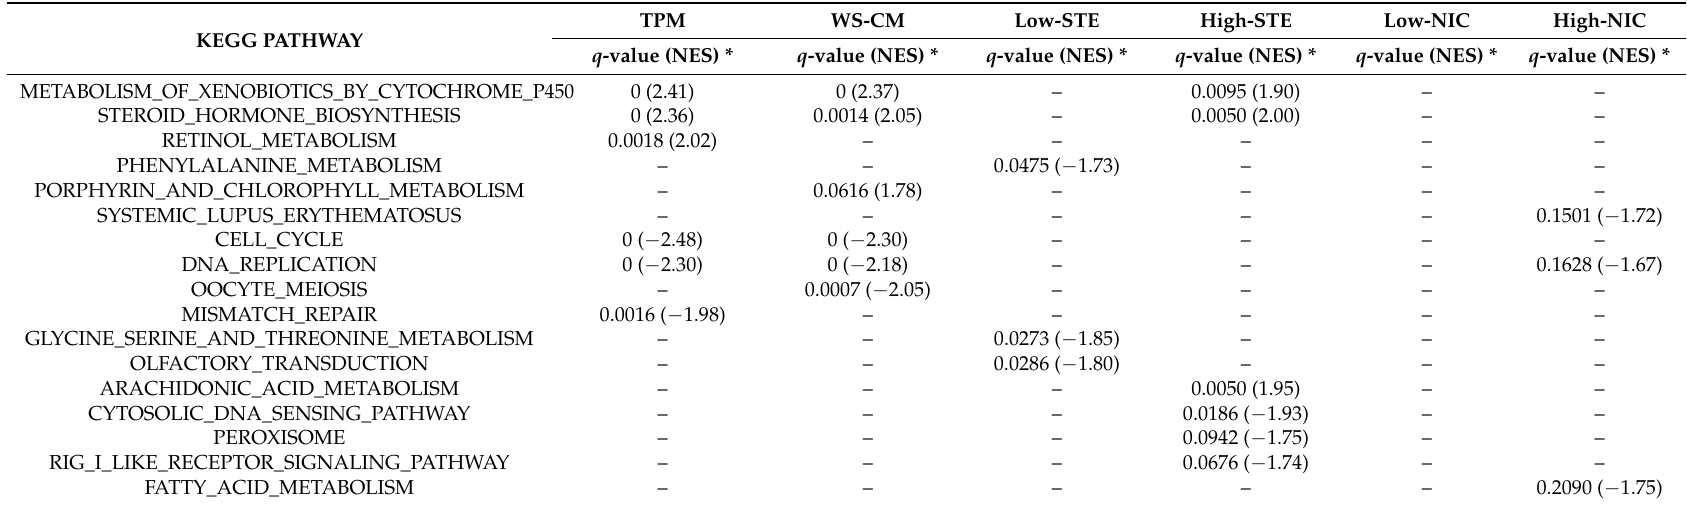
Table 3. The top 3 up- and 3 down-regulated Kyoto Encyclopedia of Genes and Genomes (KEGG) Pathways from Gene Set Enrichment Analysis for each tobacco product preparation TPP in human gingival epithelial cells